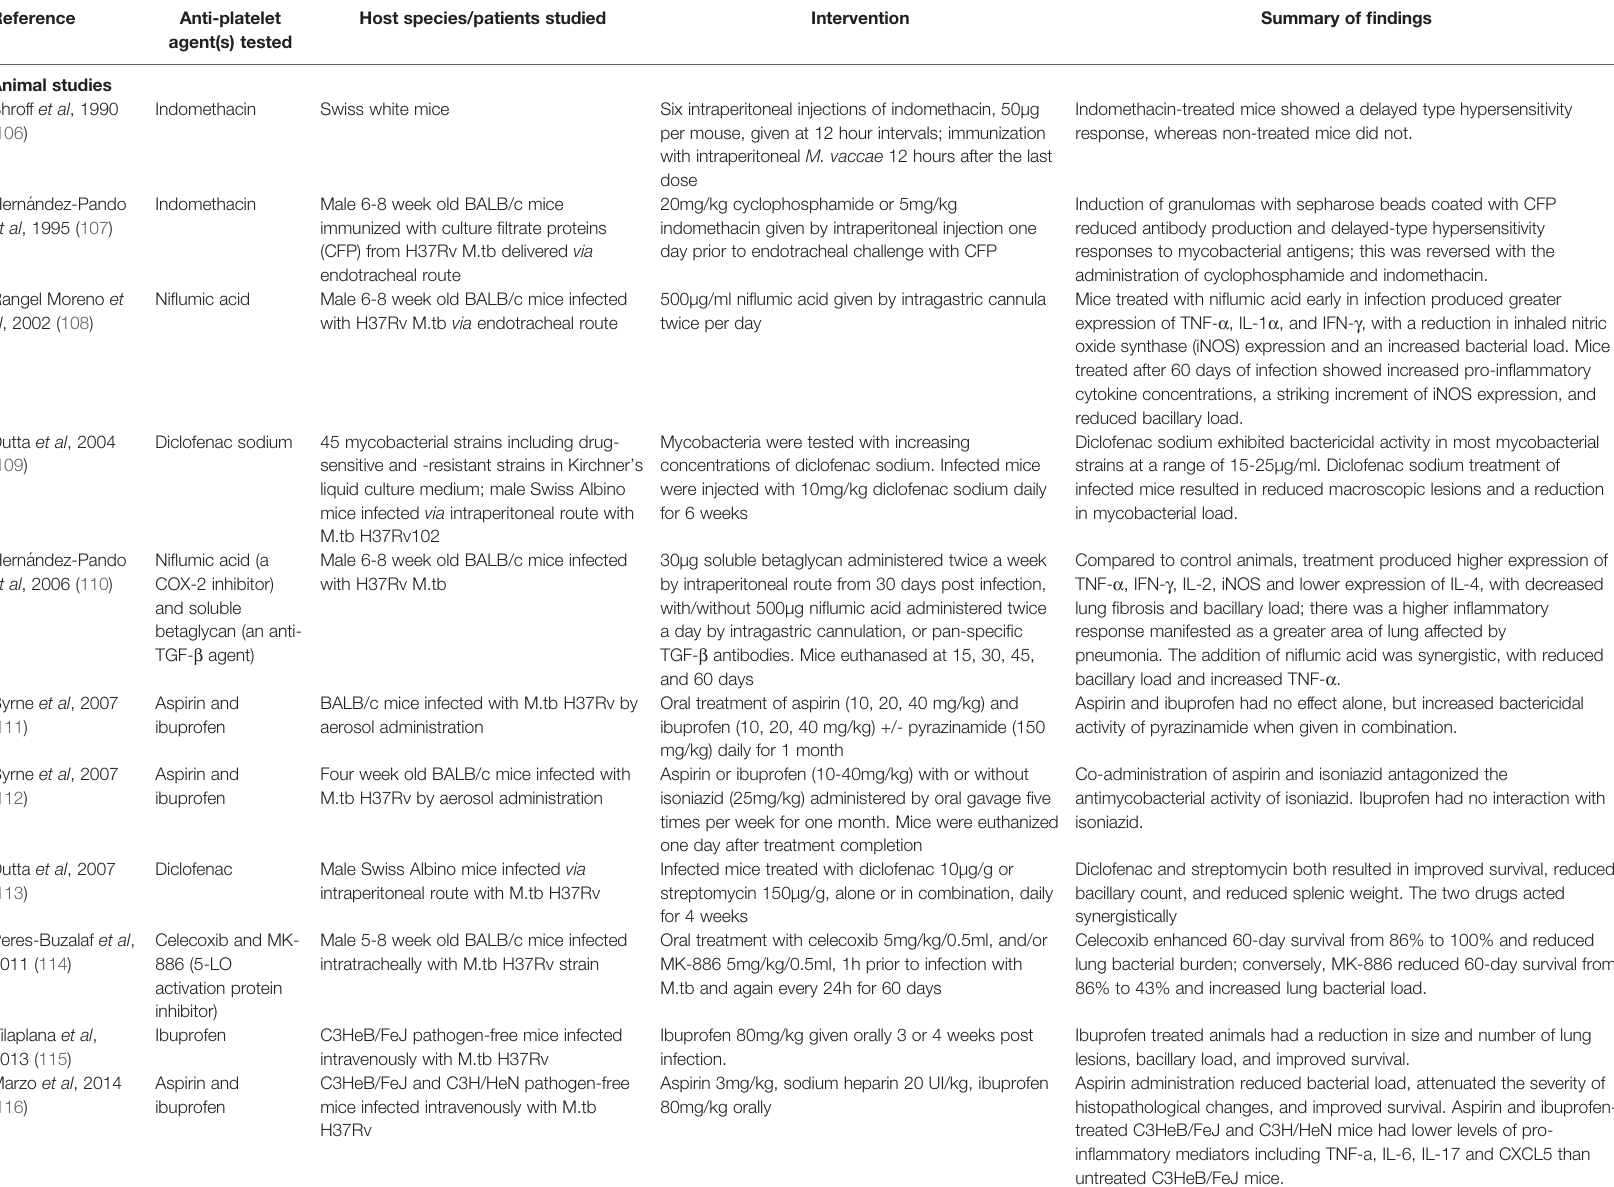
TABLE 1 | Animal and human studies investigating the effects of anti-platelet agents in tuberculosis.